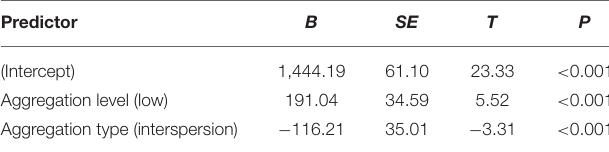
TABLE 6 | Parameter estimates in the linear mixed model for landscape preference rating as a function of aggregation level and aggregation type.